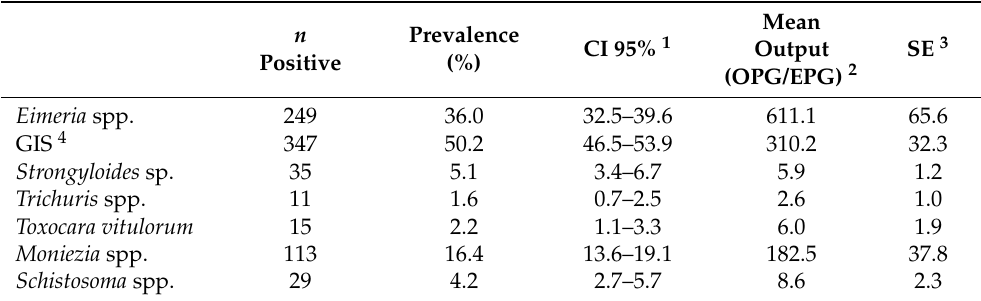
Mean n Prevalence Output CI 95% 1 SE 3 Positive (%) (OPG/EPG) 2